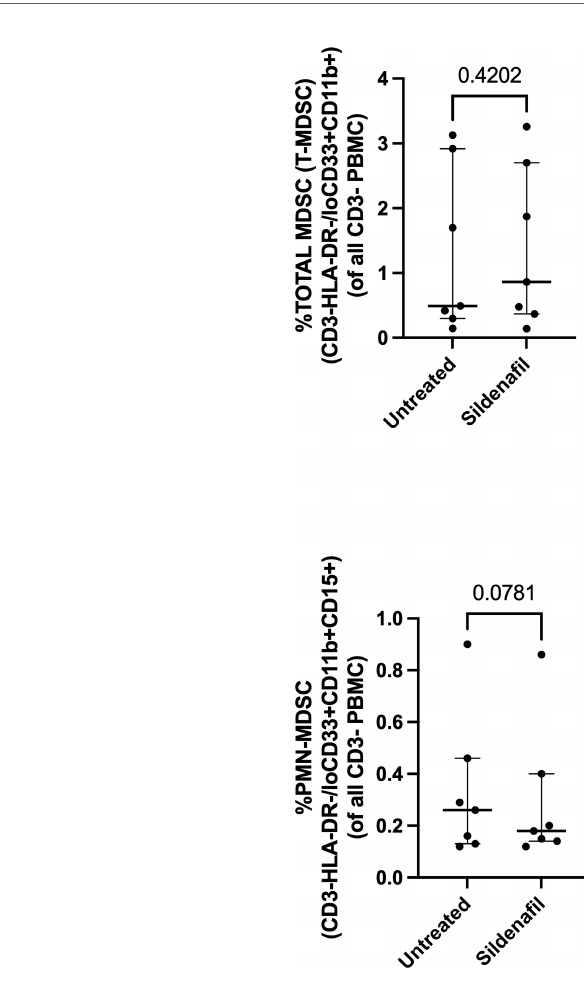
FIGURE 3 | Effect of Sildena fi l on the frequency of (A) Total MDSC, (B) M-MDSC, (C) PMN-MDSC, gated as a frequency of PBMC, from in vitro cultures of MDSC (HLA-CD33+ cells) and Control Monocytes isolated from PBMC of individuals with active TB disease (n = 7). Plots show individual TB patient data. D ’ Agostino and Pearson normality Test. Paired t test (parametric data) and Wilcoxon matched pairs signed rank test (non-parametric data). Median with interquartile range indicated on plots. P<0.05 was considered signi fi